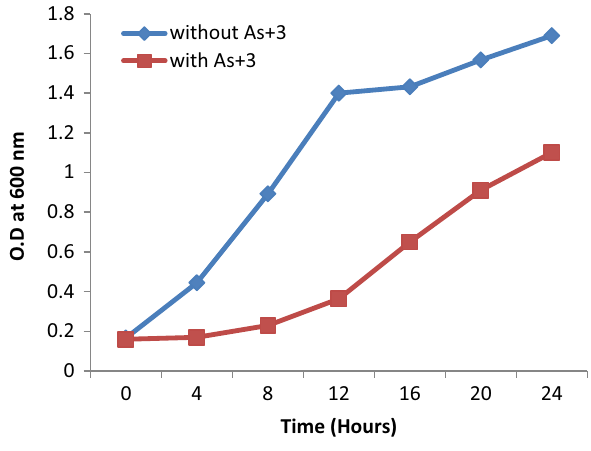
Fig. 1 Growth pattern of B. licheniformis A6 in the absence and pres- ence of arsenite (100 µg/ml) in N-broth at optimum conditions